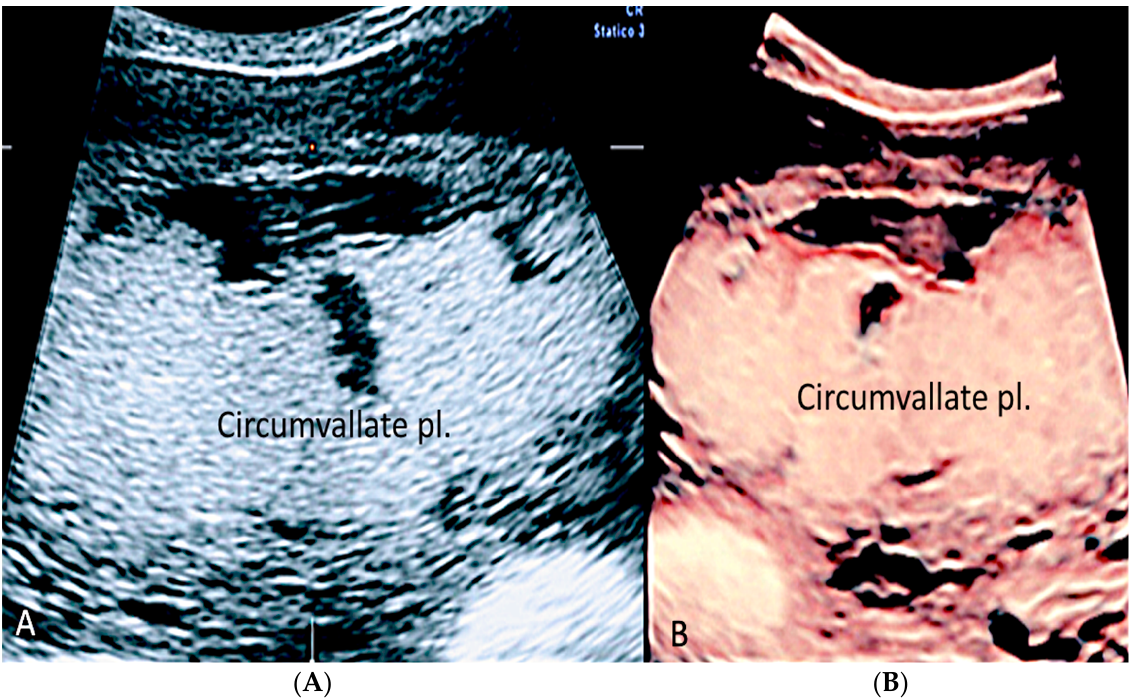
Figure 9. ( A , B ) Circumvallate placenta (pl.) with posterior placenta. Two-dimensional and three- dimensional ultrasound using HD-Live™ mode showing a “shelf-like” structure.